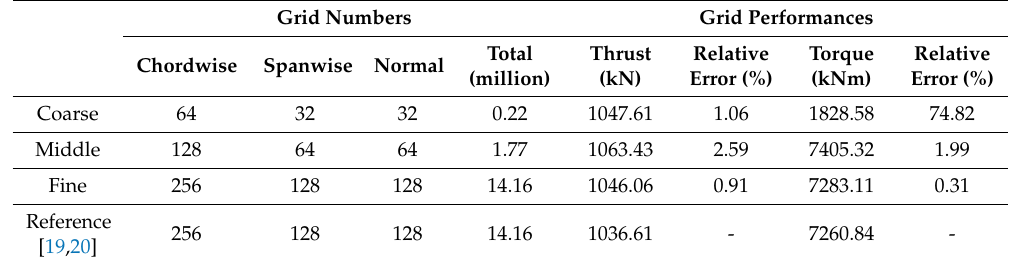
Table 1. Grid parameters and performances of grid independency